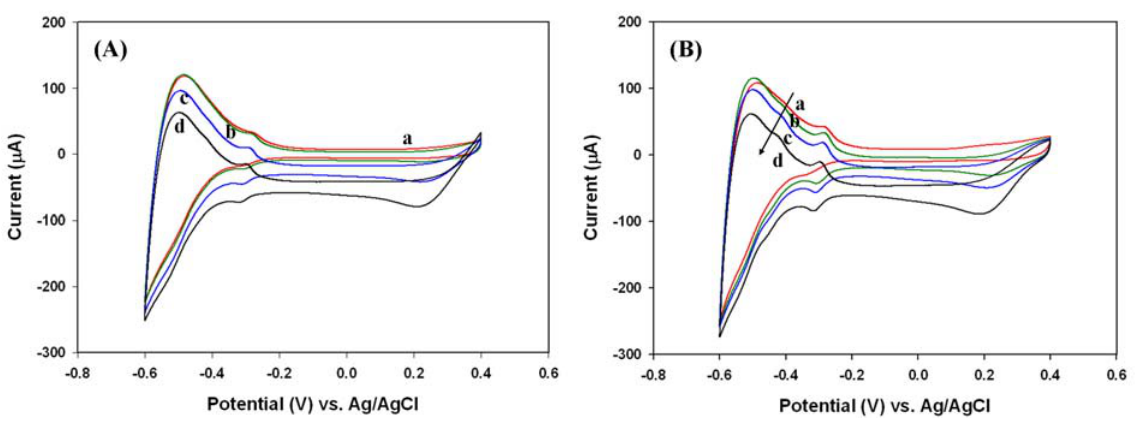
Figure 2. Cyclic voltammograms of a Pt electrode in the potential window of -0.6 ~ 0.4 V with the scan rate of 0.2 V/s in 0.1 M phosphate buffer (pH 6.2). (A) The solutions were degassed before H O was added. The concentration of H 2 2 mM for lines (a) to (d), respectively. (B) The solutions were degassed before the oxygen-saturated sample was added, and the concentration of O mM for lines (a) to (d), respectively.